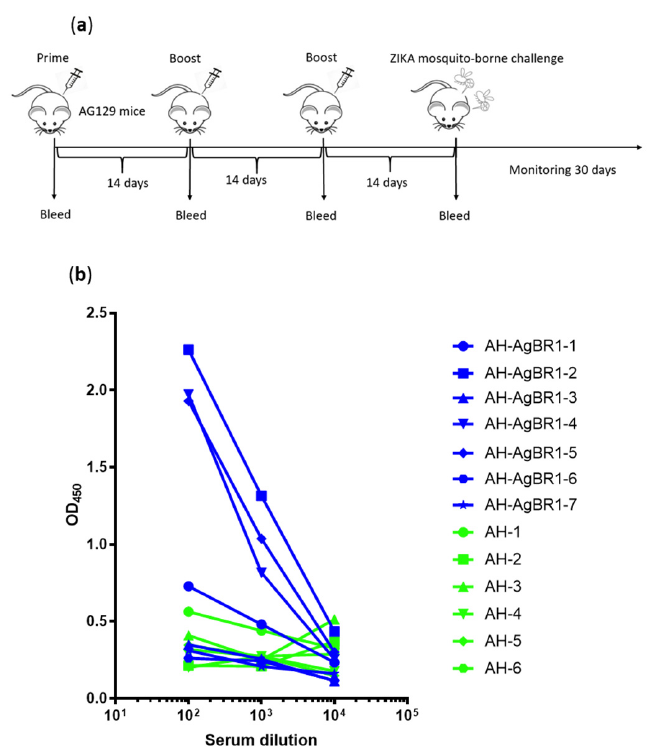
Figure 2. AG129 mice produce anti-AgBR1 antibodies after AgBR1 active immunization. 4-6 week old AG129 mice were immunized subcutaneously with 10 µ g of AgBR1 adjuvanted with AlumHydro gel at the back base on weeks 0, 2, and 4 (AH-AgBR1, n = 7) or only AlumHydro gel served as a control (AH, n = 6), following a prime–boost–boost regimen. ( a ) Schematic of the experiment. Fourteen days after prime–boost–boost immunization, mice were challenged with Zika Virus (ZIKV) via mosquito bite and mice were monitored 30 days for survival, body weight, and viremia. ( b ) Mice antibody titer against AgBR1 was tested individually one day before challenge by ELISA